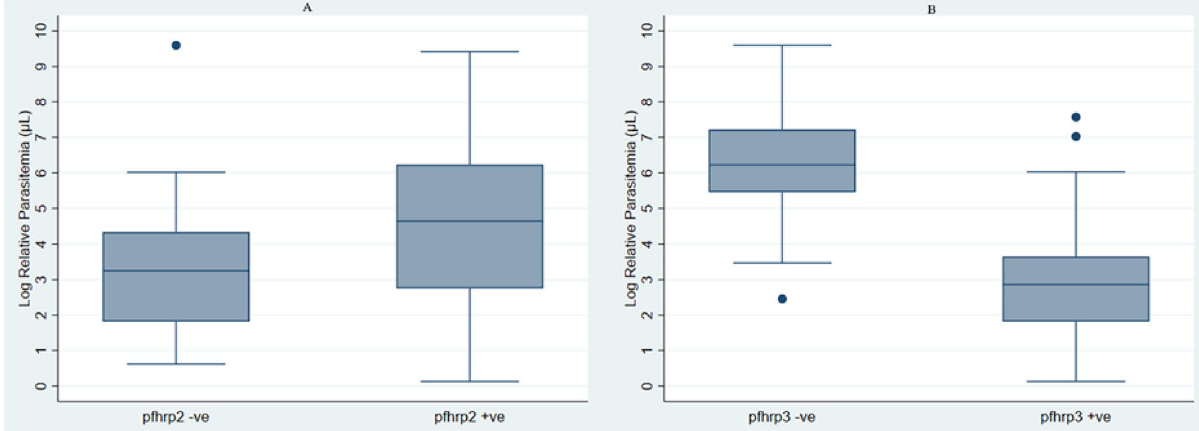
Figure 2. Parasitemia levels for pfhrp-2/3 gene negative and positive. *log back-transformation was done on median values to obtain actual